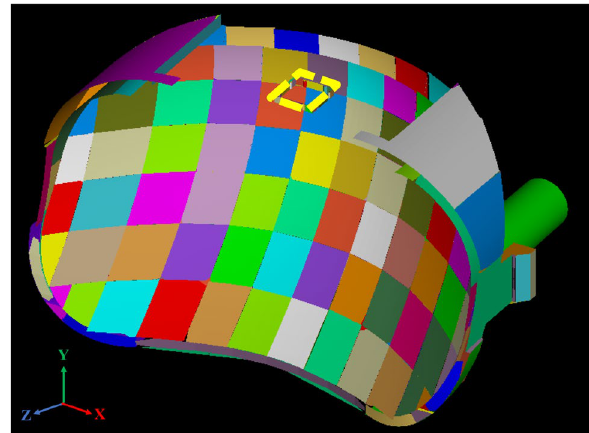
Figure 3. The geometry of the reflector with 68 segments.